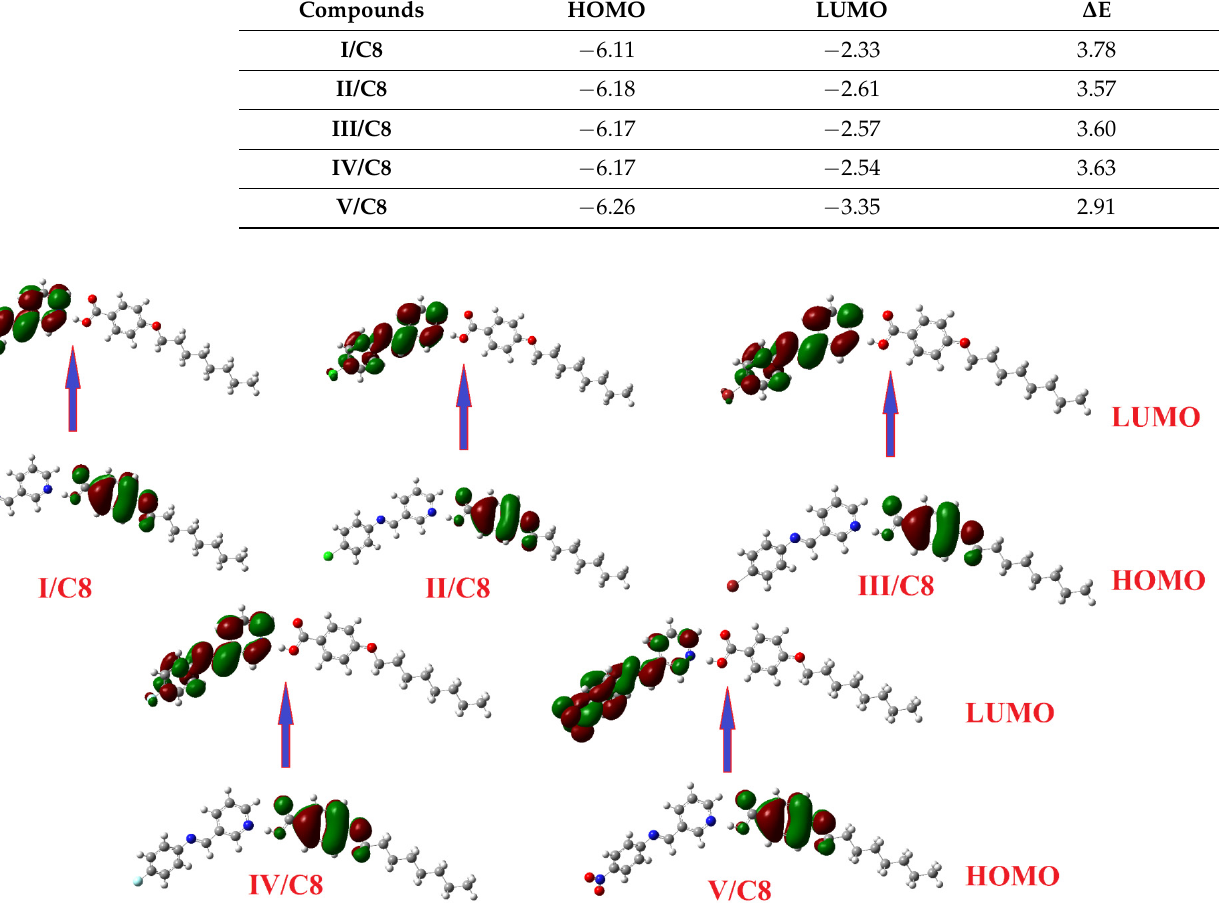
Figure 5. The calculated plots for the para-octyloxy benzoic acid supramolecular complexes, ( I-V ) C8 , frontier molecular orbitals, H (gray), C (black), N (blue) and O (red).